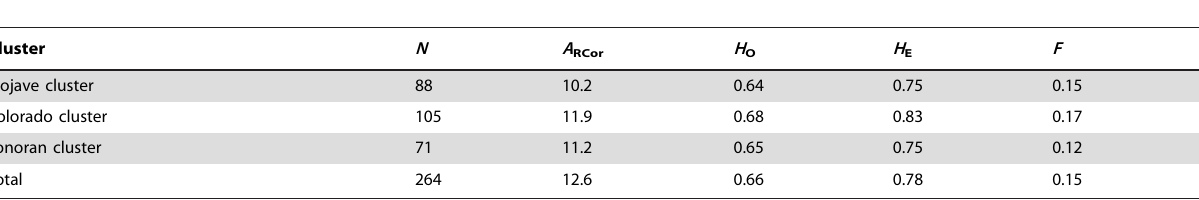
Table 3. Genetic variability of microsatellite loci for each cluster identified using STRUCTURE .